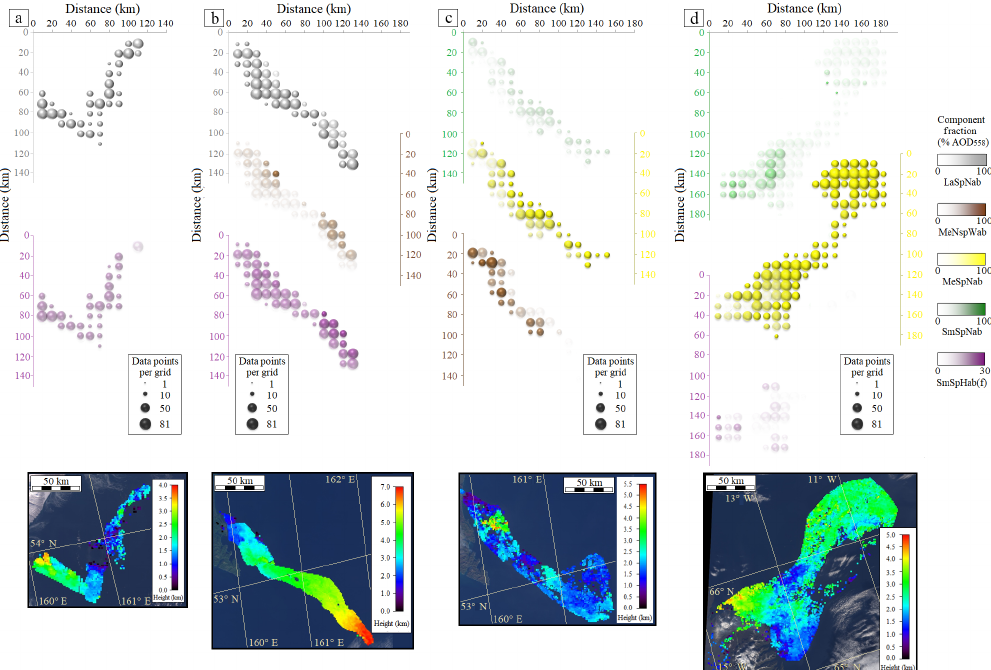
Figure 7. Analysis of MISR research aerosol retrieval algorithm (RA) retrieved particle properties (for over-ocean plume regions), aggregated to a ∼ 10km grid, with corresponding MISR stereo height retrieval maps derived using MISR INteractive eXplorer (MINX). In the upper panels, the degree of dot color saturation indicates the percent mid-visible AOD of that component, and the dot size represents the number of 1.1km retrievals within the 10km grid cell for which that component was present in the retrieval results. Plumes were emitted from Karymsky volcano on (a) 31 January 2011 (orbit: 59148; path: 99; block: 47), (b) 3 September 2007 (orbit: 41003; path: 97; blocks: 47–48), (c) 5 October 2007 (orbit: 41469; path: 97; blocks: 47–48) and (d) Holuhraun, Iceland, emitted on 25 September 2014 (orbit: 78567; path: 214; blocks: 37–38). Particle types: small, spherical, highly absorbing (SmSpHab(f)); small, spherical, non-absorbing (SmSpNab); medium, spherical, non-absorbing (MeSpNab); large, spherical, non-absorbing (LaSpNab); medium, non-absorbing dust grains (MdNspWab). Note: the elevation scales vary between the panels, and particle concentrations scales vary by component